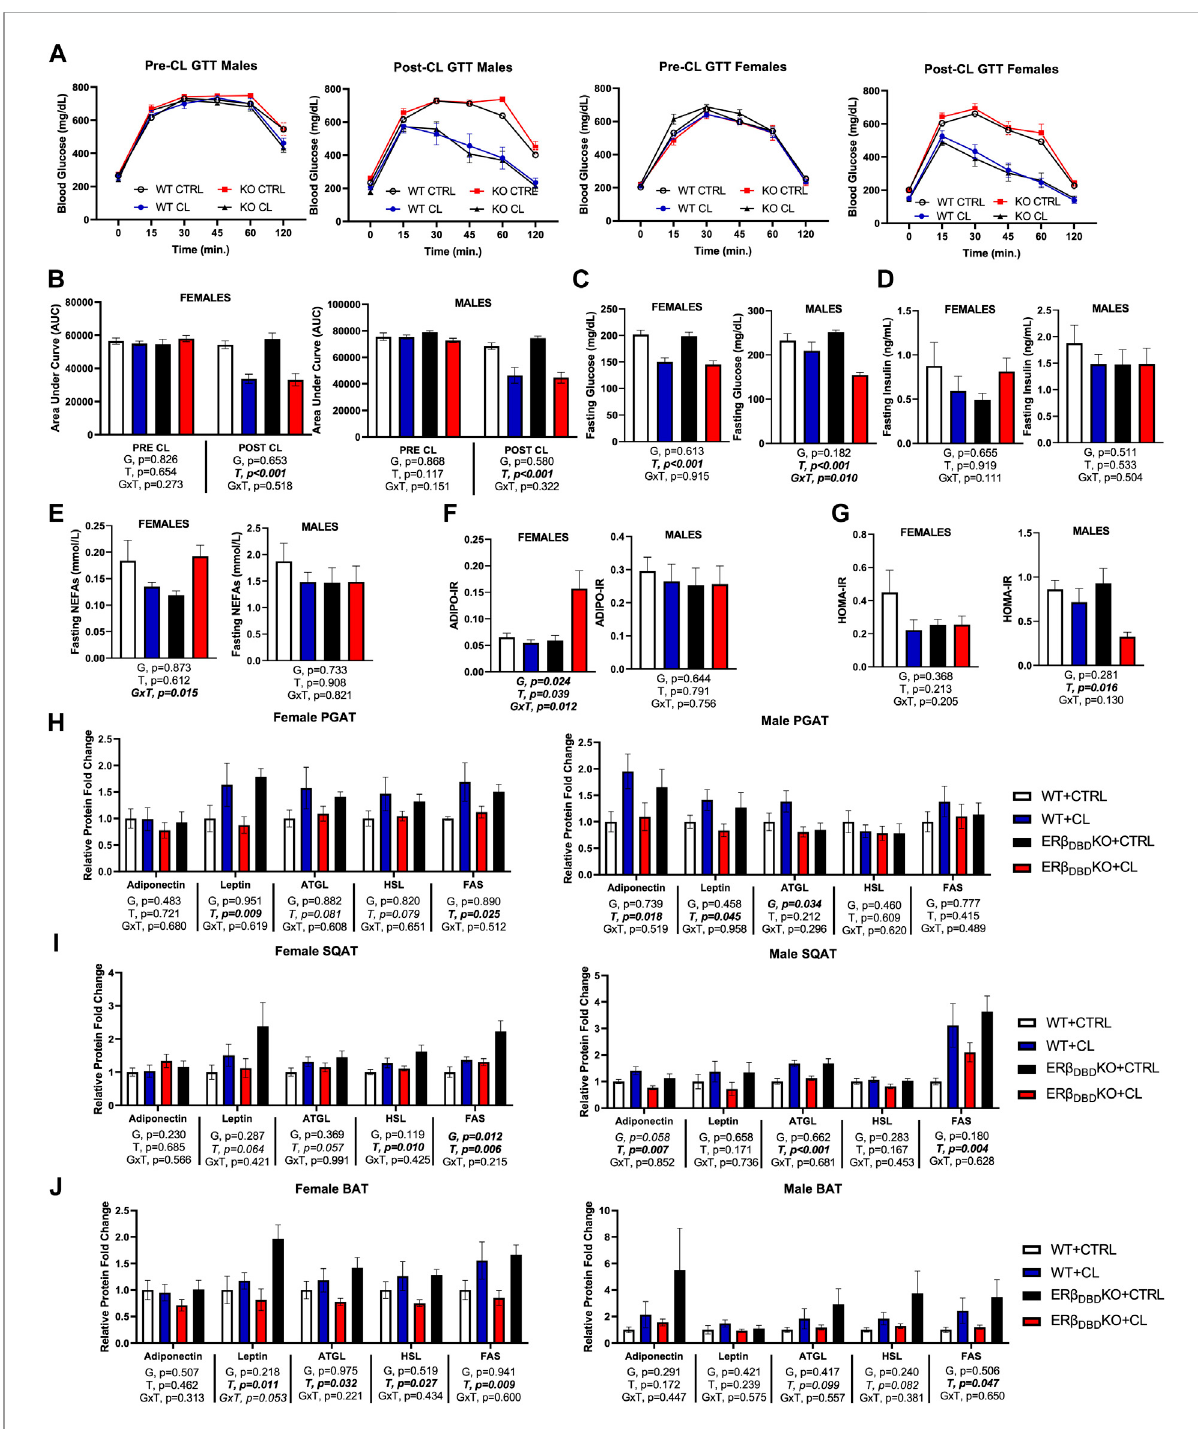
FIGURE 3 ER β genomic activity is not required for CL-induced improvements in glucose homeostasis, or the augmentation of basal lipolytic response. Male and female C57BL/6J wild-type (WT) or Estrogen Receptor Beta (ER β )DNA binding domainknockout (ER β DBD KO) mice, all on HFD, were given 2-weeks CL injection (1ug/g body wight) or CTRL (saline). Glucose tolerance tests (GTT) were performed and blood biomarkers were measured to assesstheeffect ofCLon glucose homeostasis. (A) GTTresponsegraphsbefore andafter CLtreatment. (B) GTTareaundercurve(AUC) before and after CL treatment. (C) Fasting blood glucose. (D) Fasting blood insulin. (E) Fasting blood non-esteri fi ed fatty acids (NEFAs). (F) Adipose tissue insulinresistance(ADIPO-IR)=fastingNEFAconcentration(mmol/L)xfastinginsulinconcentration(pmol/L). (G) HomeostaticModelAssessmentfor InsulinResistance(HOMA-IR)=fastinginsulin(microU/L)xfastingglucose(nmol/L)/22.5.Atsacri fi ce,perigonadal(PGAT),subcutaneous(SQAT)and